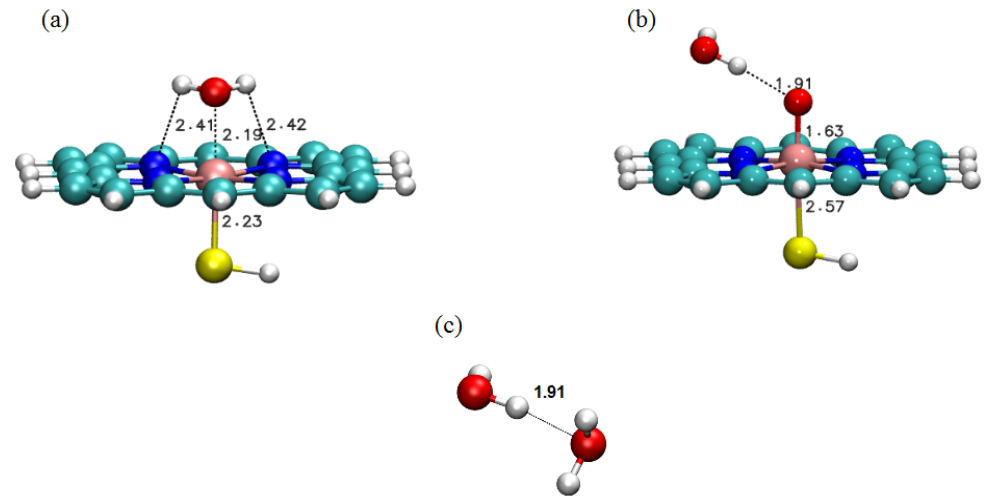
Figure 2. Optimized geometries of ( a ) 1 , ( b ) 2 , and ( c ) 3 . Distances are in